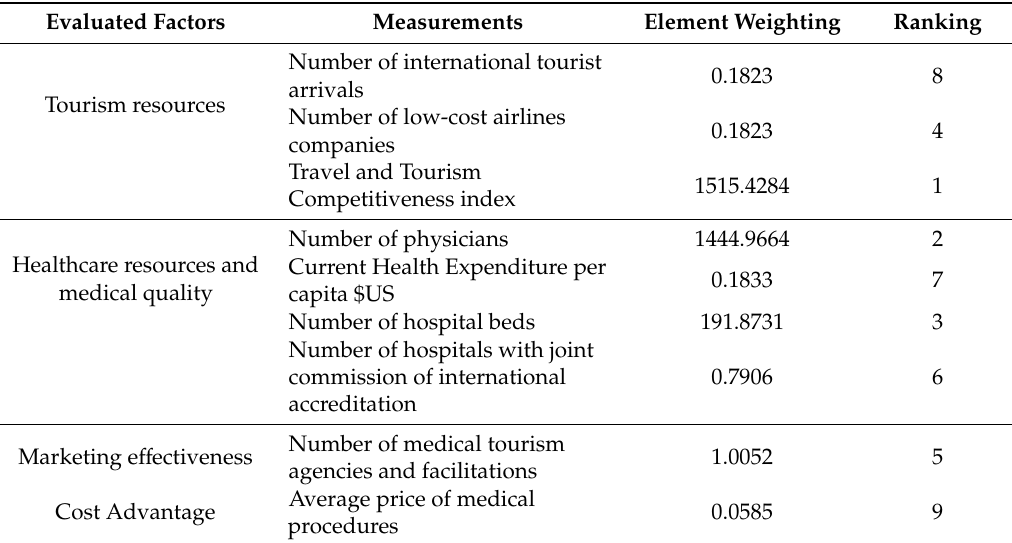
Table 2. The results of factor analysis by the GM (0,N)